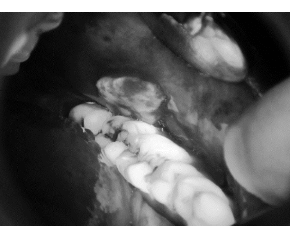
Figure 18. VELscope ® image with no circular area detected.